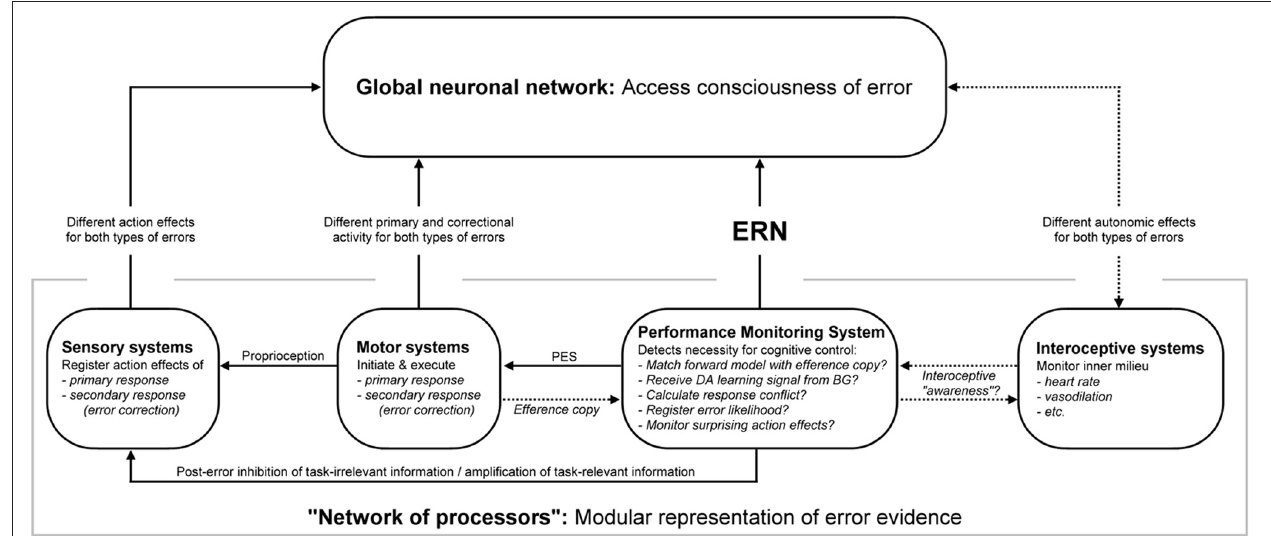
FIGURE 3 | A putative model schematic of emerging error awareness in the human brain, based on the accumulating evidence account of error awareness and the global neuronal workspace model. Information about the accuracy of an action is processed in parallel in different areas that comprise the “network of processors,” which feeds forward into the GNW. Note that the flow of information indicated by the arrows is only depicted if potentially meaningful for error awareness. Additional exchange of